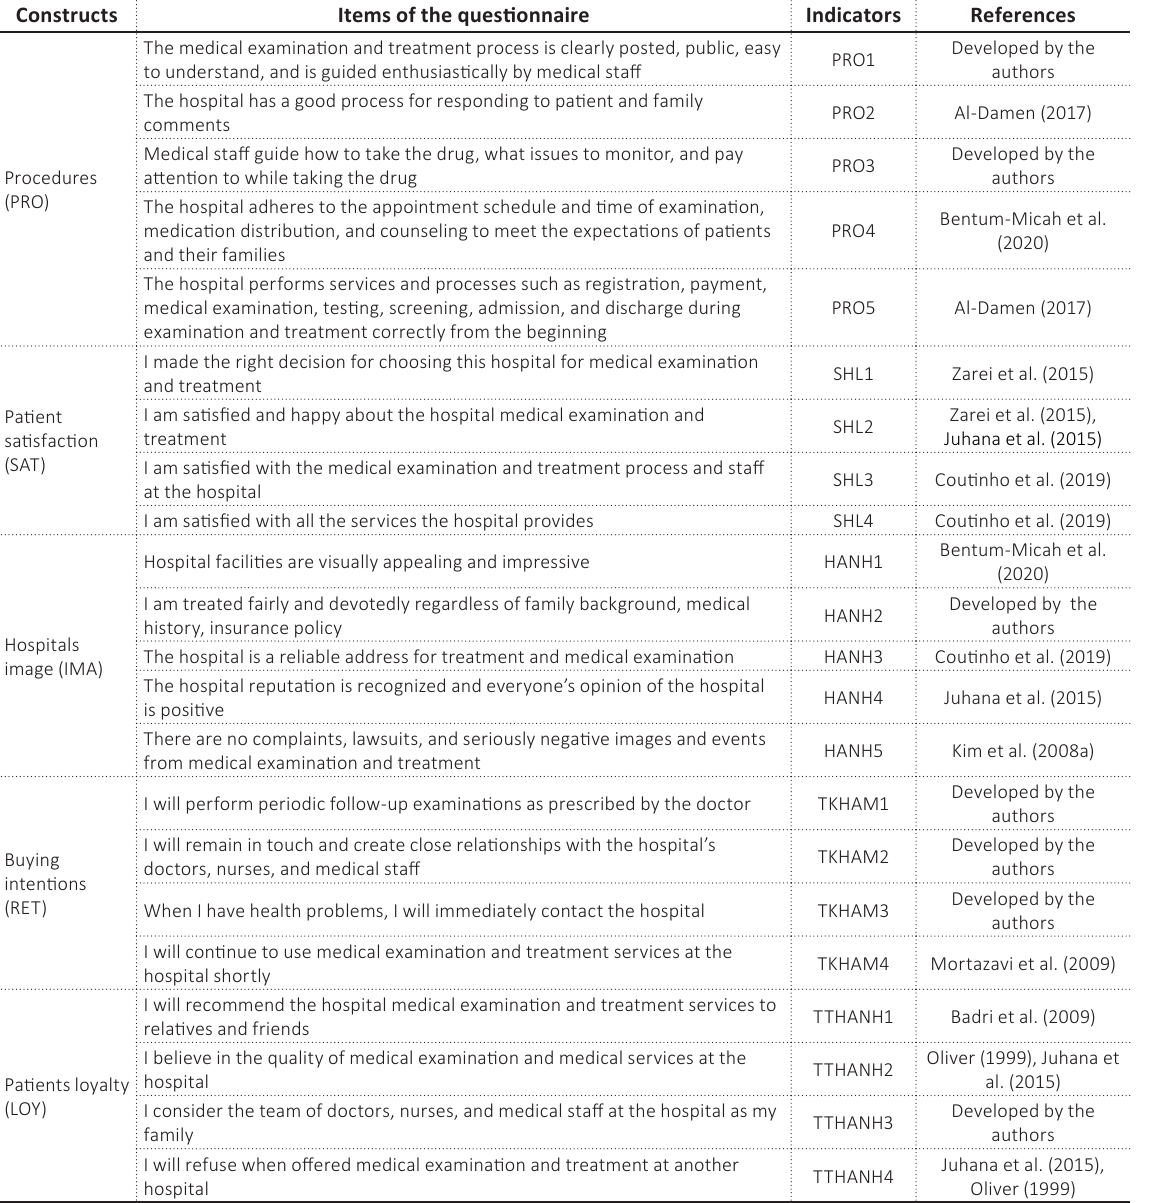
Table 1 (cont.). Questionnaire